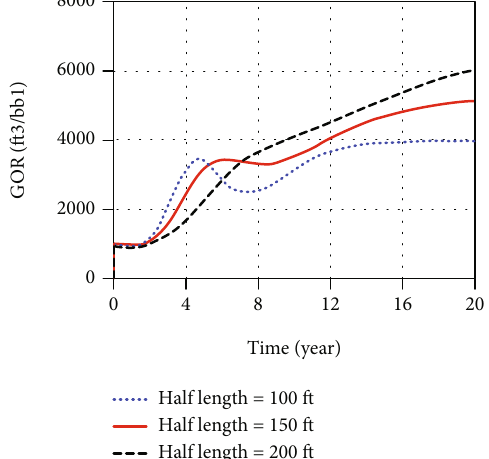
Figure 12: E ff ect of hydraulic fracture half-length on GOR rise versus time. Fractures with longer length leads to a mitigation in GOR